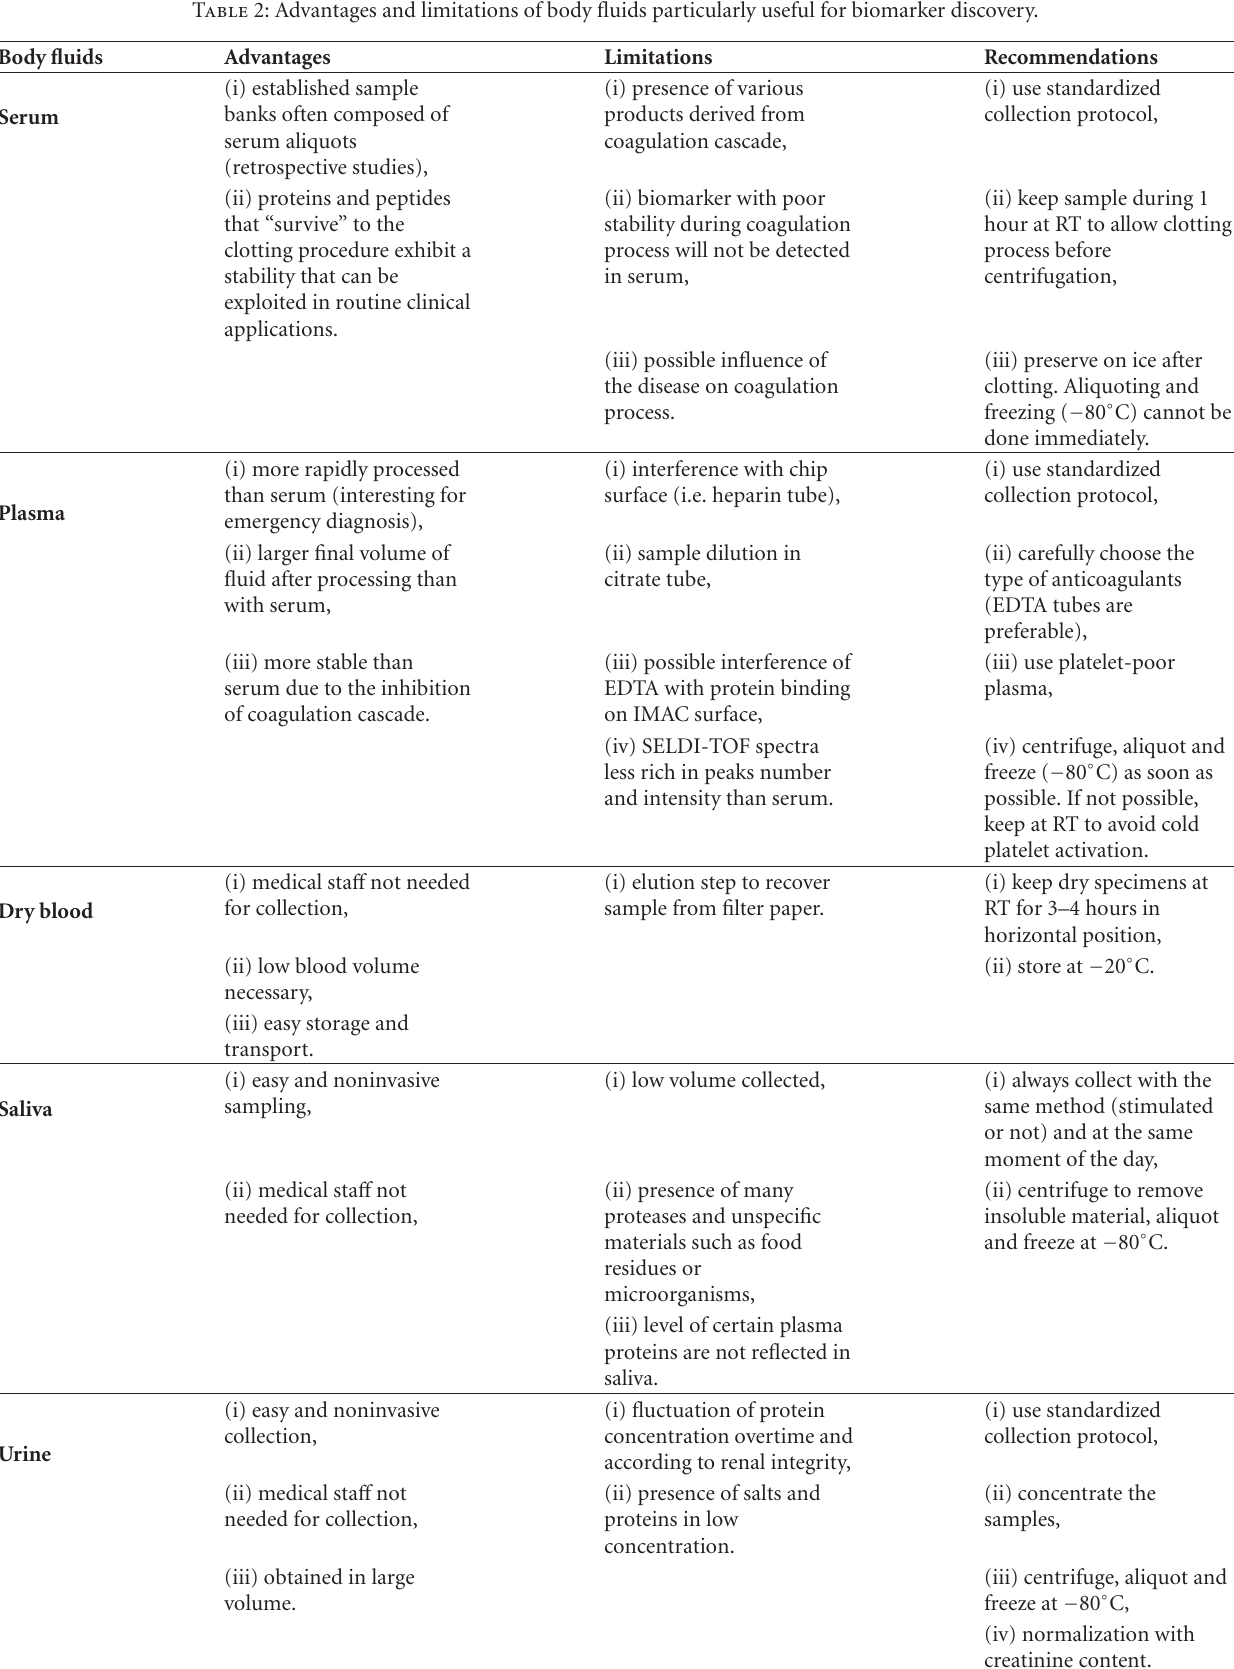
Table 2: Advantages and limitations of body fluids particularly useful for biomarker